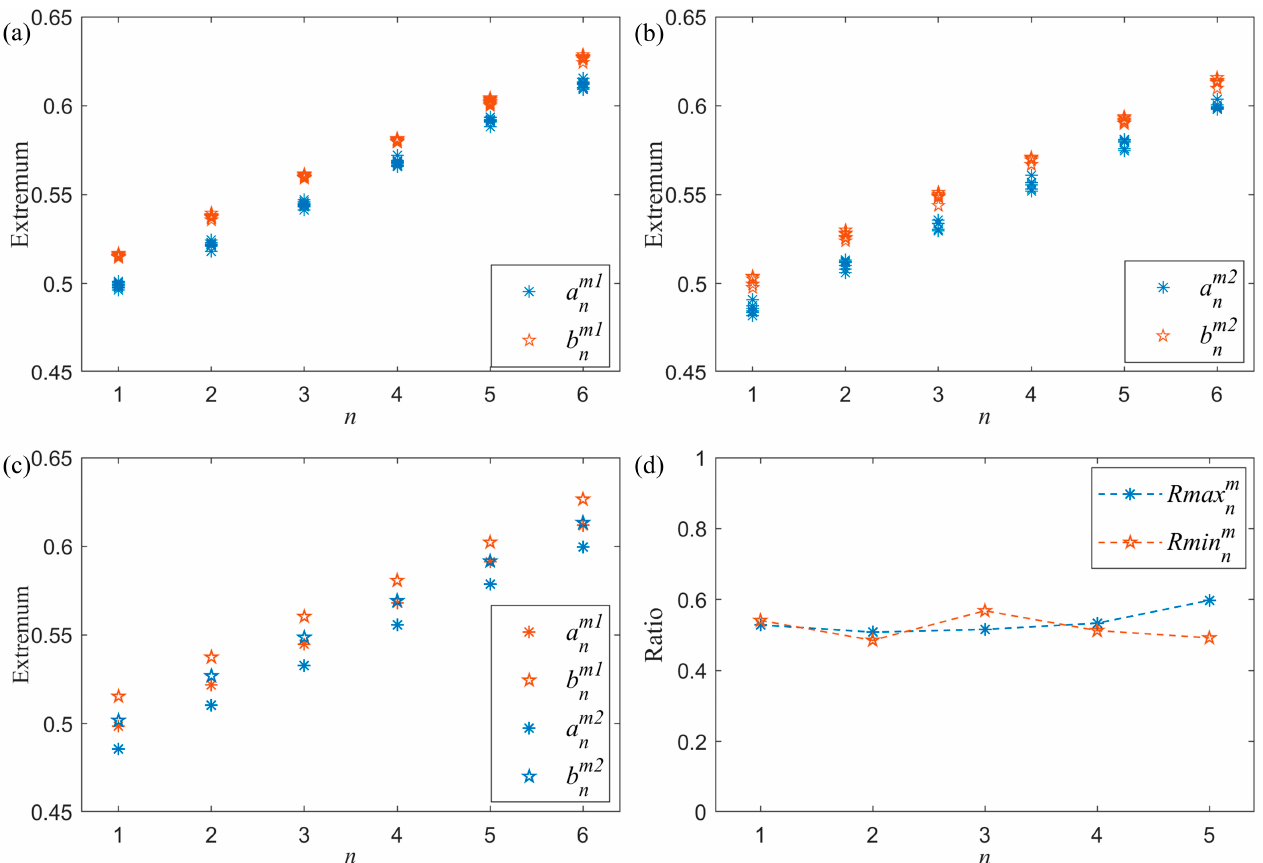
Figure 11. Measurement results of amplitude-division interference experiments at high signal-to- noise ratios. ( a ) extrema of the normalized interference term I ∆ of the coupler output 1; ( b ) extrema of the normalized interference term I ∆ of the coupler output 2; ( c ) average of the corresponding extrema of the normalized interference terms I ∆ of the two outputs; ( d ) Rmax m n and Rmin m n calculated from the extrema.